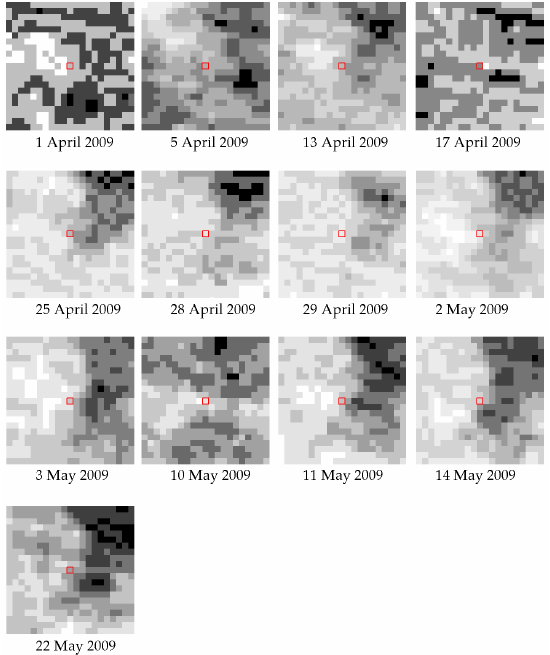
Figure 8. BTs distribution from band 7 for 13 IRS images. The red pixel is the inspected pixel in the window.